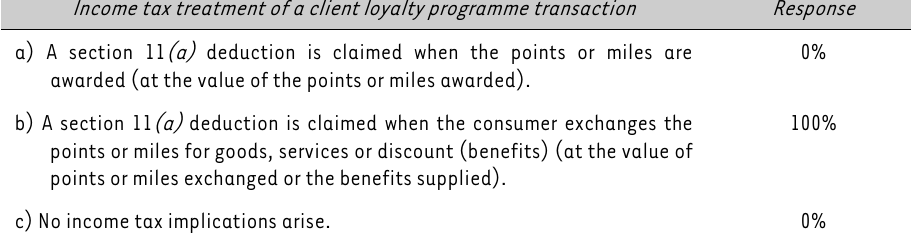
Income tax treatment of a client loyalty programme transaction for category 1 client loyalty